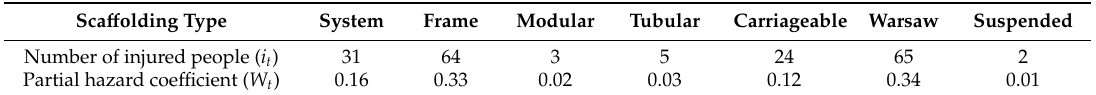
Table 1. Sca ff olding type. Table 1. Scaffolding type.